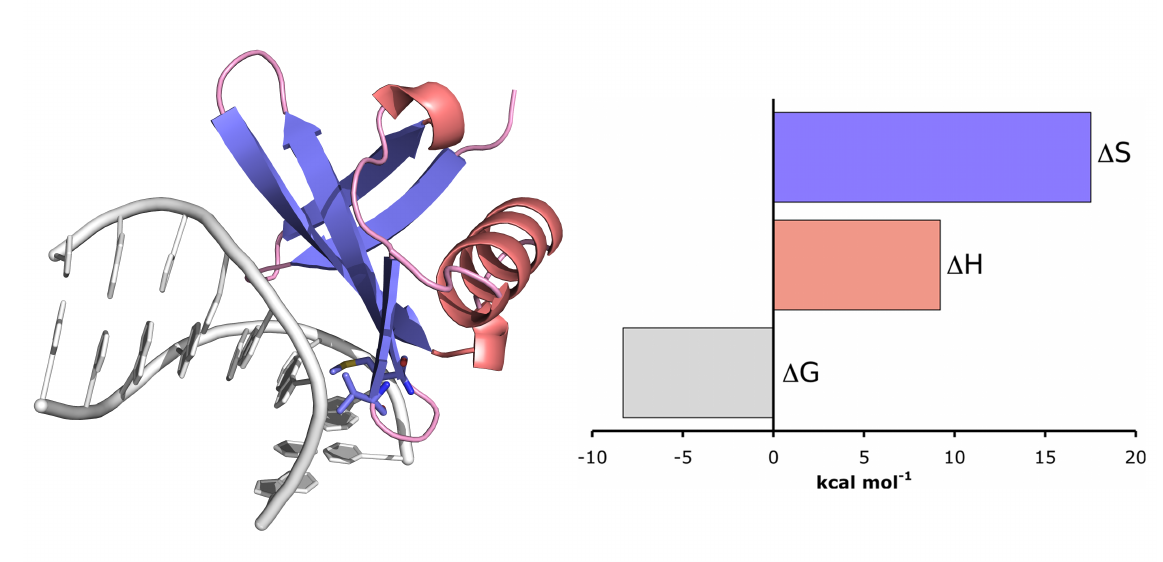
Figure 4. The crystal structure of chromatin protein Sac7d bound to a nucleic acid fragment (PDB ID: 1AZP) demonstrates that binding induces a 66 – kink in the structure of DNA. Thermodynamics of the binding event determined by application of the non-cooperative McGhee–von Hippel model to ITC data demonstrates that binding is characterised by a favourable entropy term and an unfavourable enthalpy term attributed to the energetic penalty of kinking